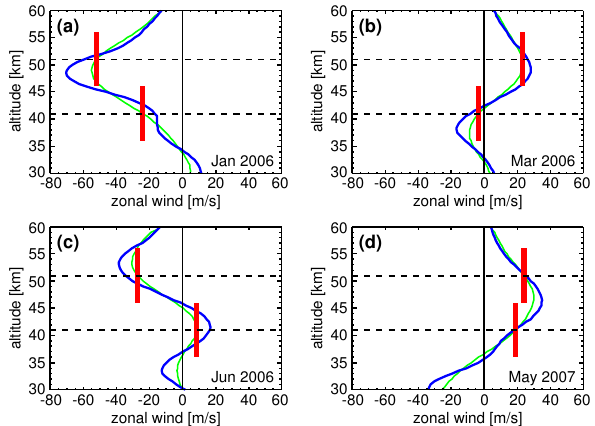
Figure 5. Zonal wind altitude profiles averaged over 10 ◦ S–10 ◦ N and 1 month for (a) January 2006, (b) March 2006, (c) June 2006, and (d) May 2007. These four situations roughly represent the four cases introduced in Fig. 4. The zonal wind (blue) and the zonal wind smoothed by a 10km vertical running mean (green) are shown in the above. The red vertical bars indicate the average zonal wind and the altitude ranges for which gravity wave momentum flux spectra are calculated. These altitude ranges are centered at z 1 = 41km and z 2 = 51km (horizontal dashed